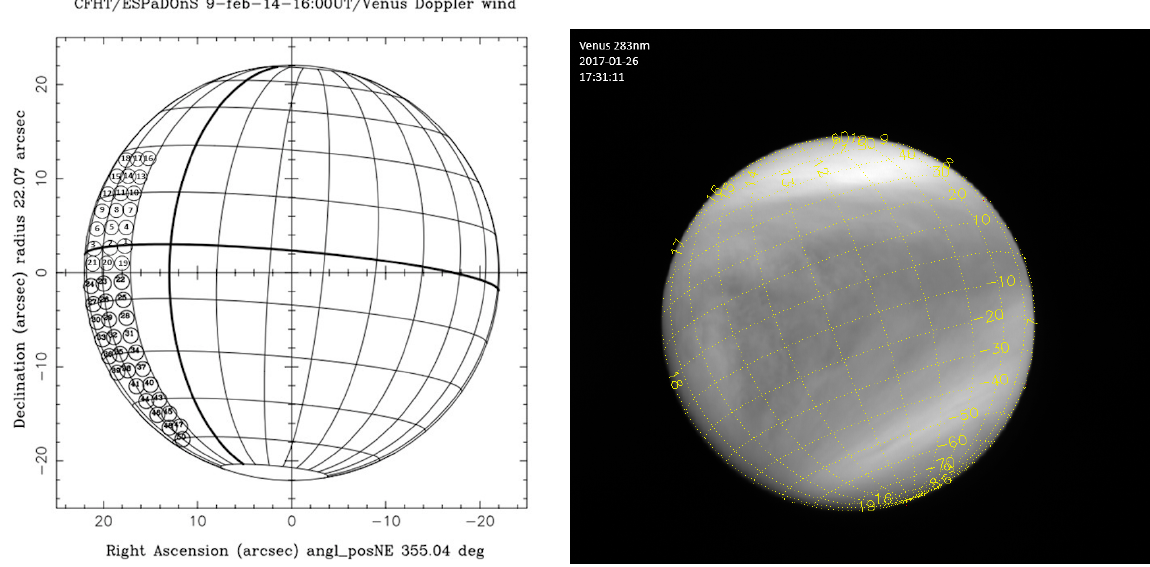
Figure 1. Observations’ strategy with the Canada-France-Hawaii Telescope (CFHT) and the high-resolution spectrograph ESPaDOnS (Echelle SpectroPolarimetric Device for the Observation of